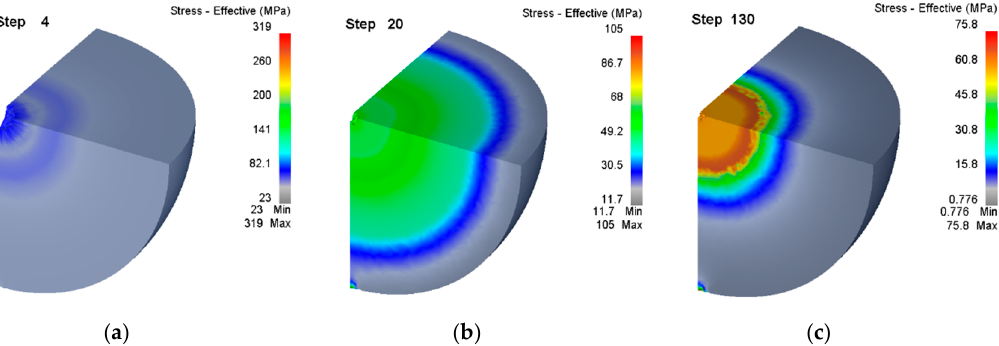
Figure 9. Closure law of equivalent stress distribution in the whole steel ball. ( a ) The beginning of compacting the void; ( b ) At step 20, the stress is approach to the void and its magnitude is gradually increasing; ( c ) The final step of compacting the void.